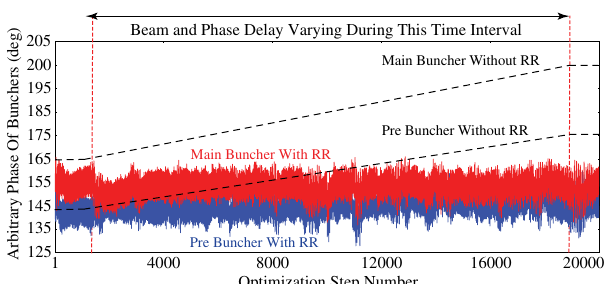
FIG. 14. Evolution of the buncher phase settings, during, and after variation of beam and phase delay